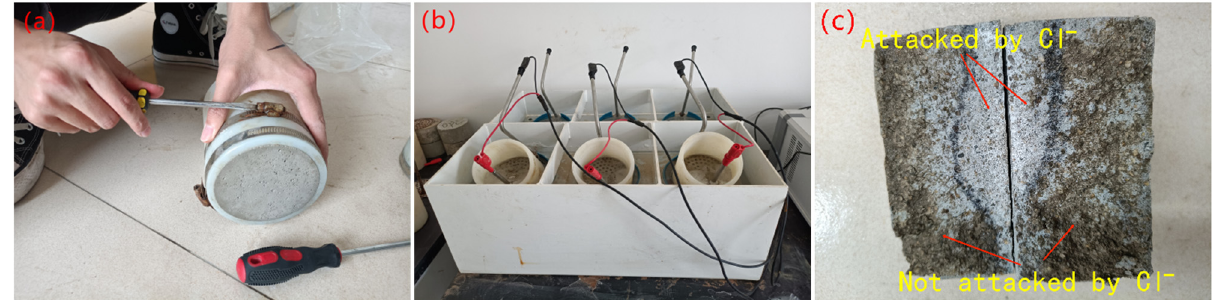
Figure 7: RCM test procedure of GOPARMs: ( a ) rubber sleeve installation; ( b ) power penetration; ( c ) section color change after spraying silver